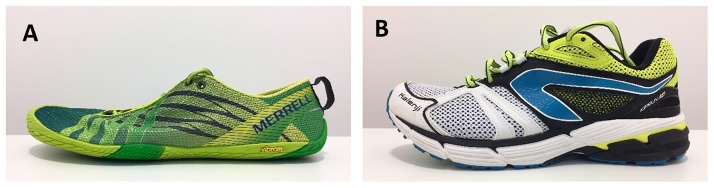
Sports shoes used for the study.A: Minimalist shoes (MIN); B: Cushioned shoes (CUSH).